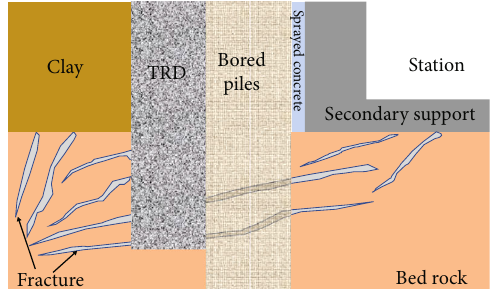
Figure 14: Longitudinal schematic diagram of the wall into the